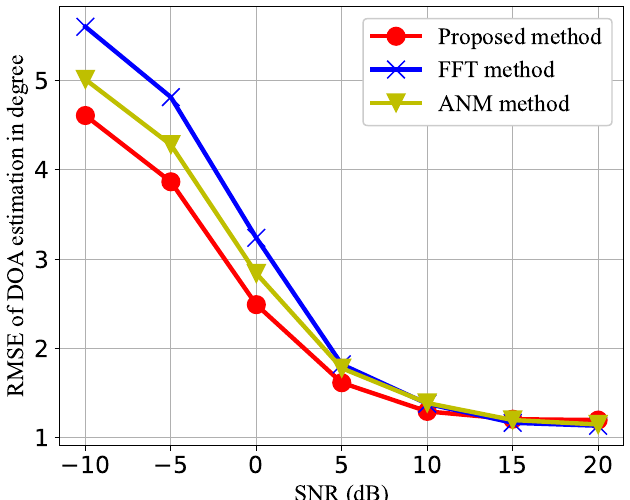
Figure 15. The root mean square error (RMSE) of the DOA estimation using 3-bit ADC to show the performance of the proposed networks.